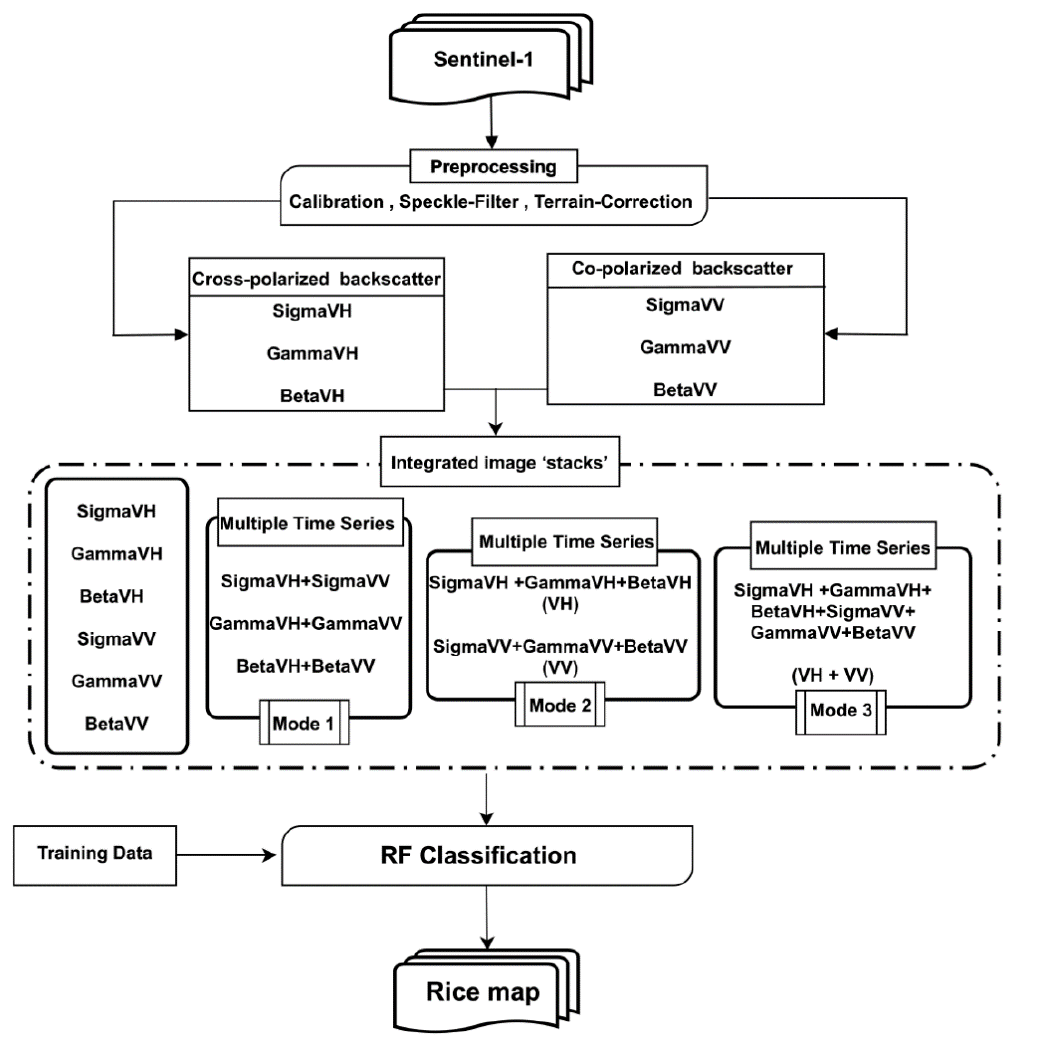
Figure 3 . Overview of the methodology for mapping rice areas using the Sentinel-1 time series